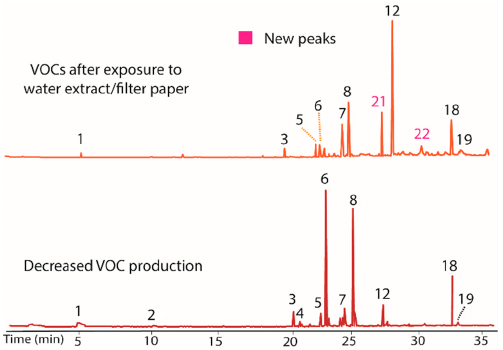
Figure 4. Chromatograms showing the influence of the water extract/filter paper of VOC production of BS15. Peaks 7 , 12 , and 18 increased upon exposure to the water extract while 6 decreased ( top ) versus BS15 with diminished VOC production ( bottom ). The water extract thus appeared to contain a modulator of VOC production. Peaks 21 and 22 were again observed to occur in both the water extract and in the control containing only filter